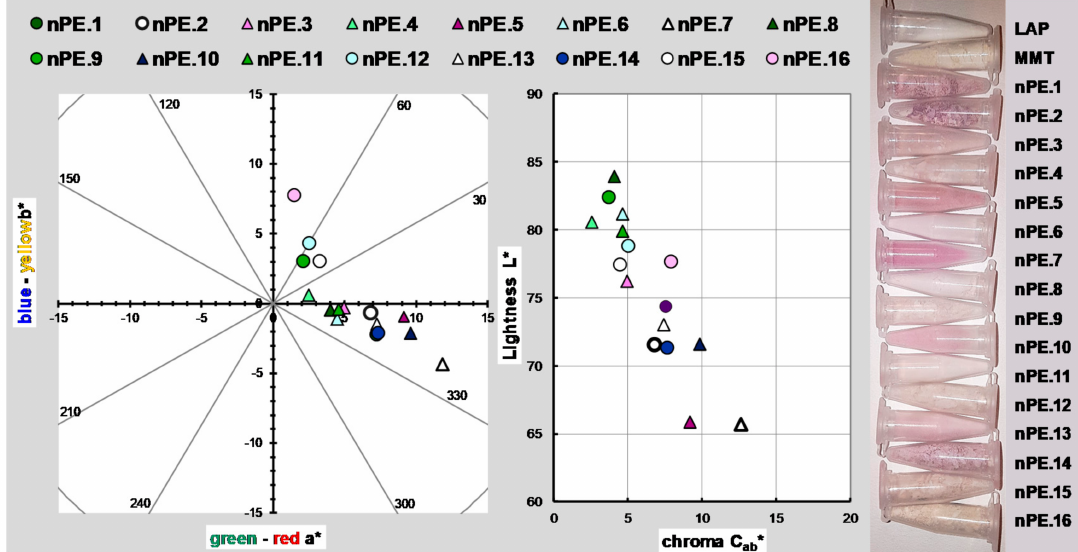
Figure 5. Graphic CIELAB plots for the PE hybrid pigments under different synthesis conditions [nPE.1–nPE.16] using the D65 illuminant and the CIE-1931 XYZ standard observer. Left : CIE-a* b* color diagram; right : CIE-C ab * L* color chart.